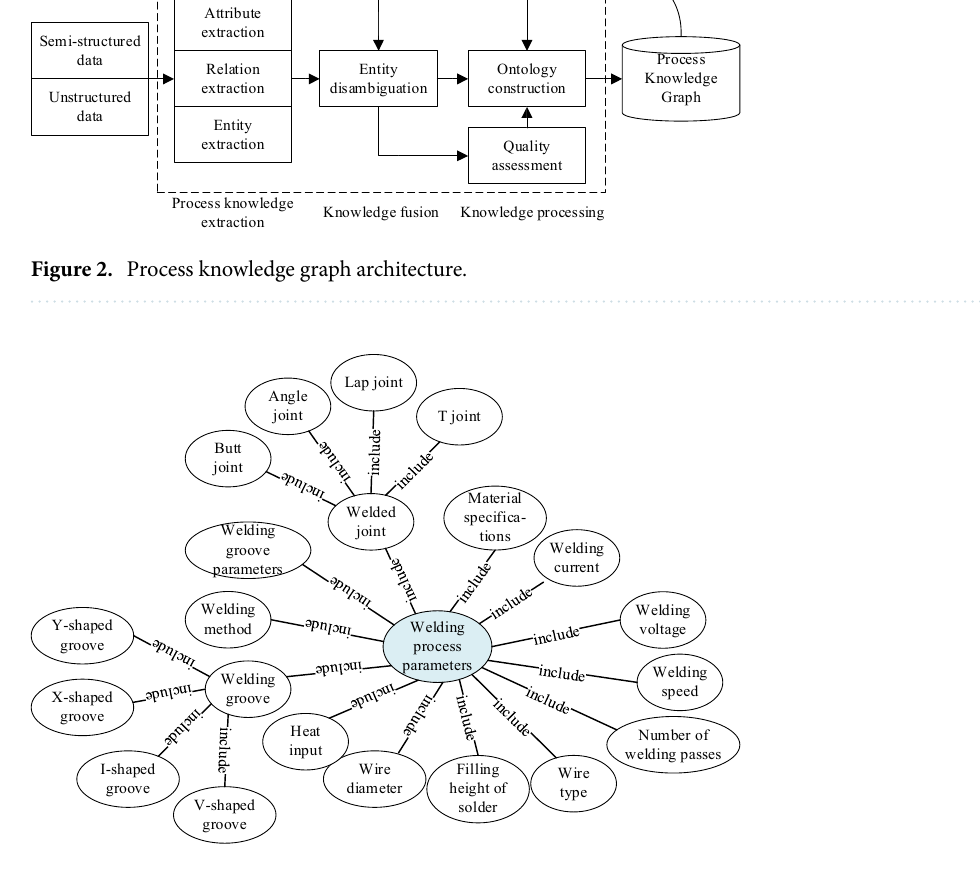
Figure 3. Entity extraction of welding process parameters in heterogeneous